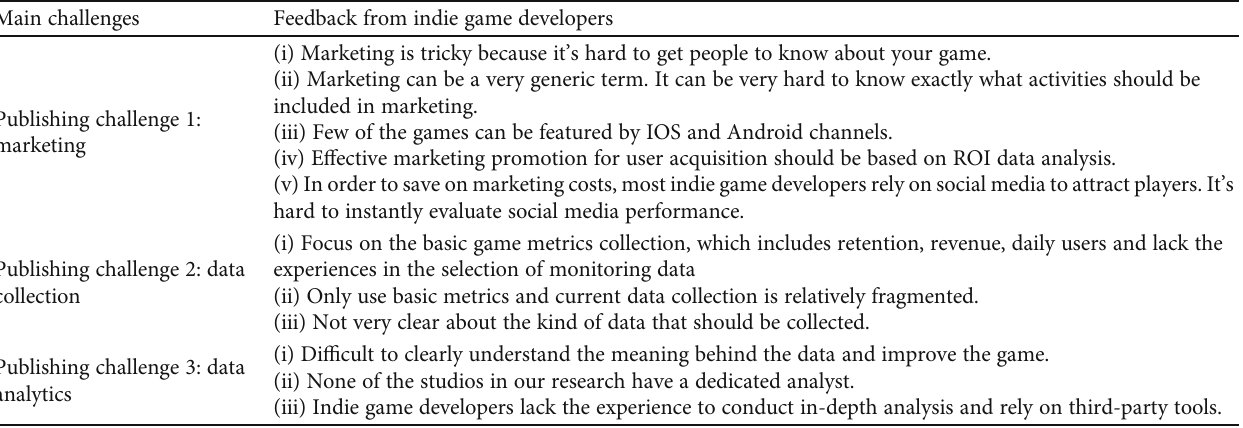
Table 2: Main challenges for indie game